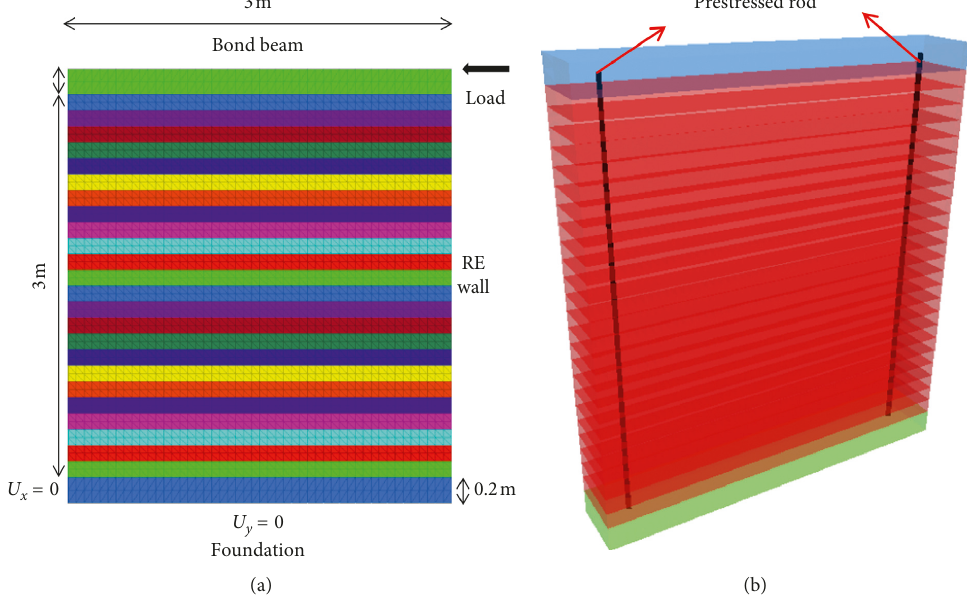
Figure 2: Mesh and boundary conditions of an RE